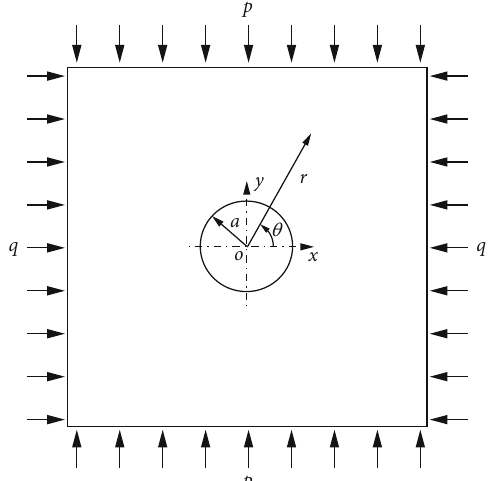
Figure 1: Model for a circular tunnel in transverse